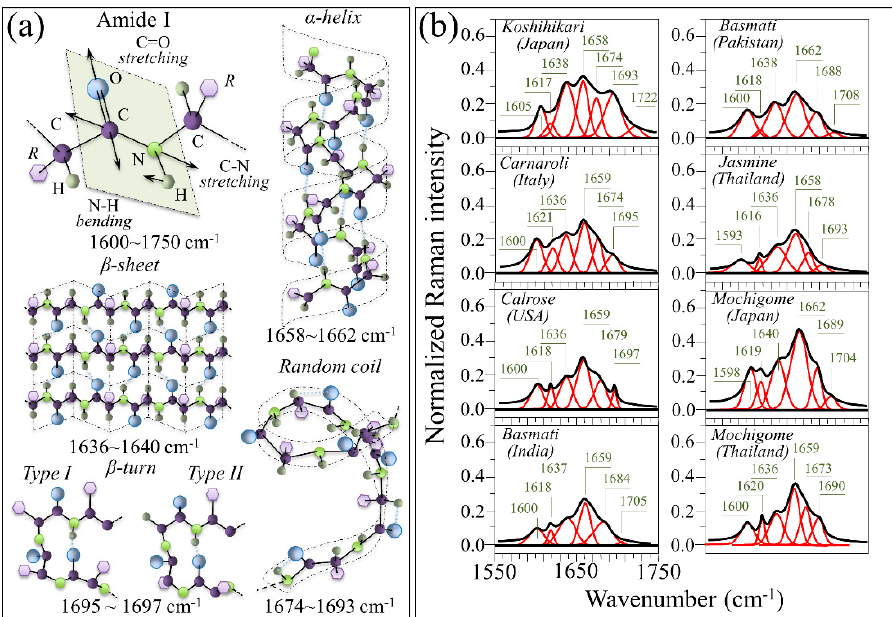
Figure 7. ( a ) The Amide I vibrational mode and schematic drafts of protein secondary structures including β -sheet, α -helix, random coil, and β -turn (related Raman frequencies in inset); ( b ) decon- voluted Raman spectra in the Amide I region (i.e., 1550–1750 cm − 1 ) for the eight investigated rice cultivars (cf. labels in inset). The spectra are normalized to their respective glucose ring stretching signals at ~478 cm − 1 and wavenumbers in inset are given in cm − 1 units.